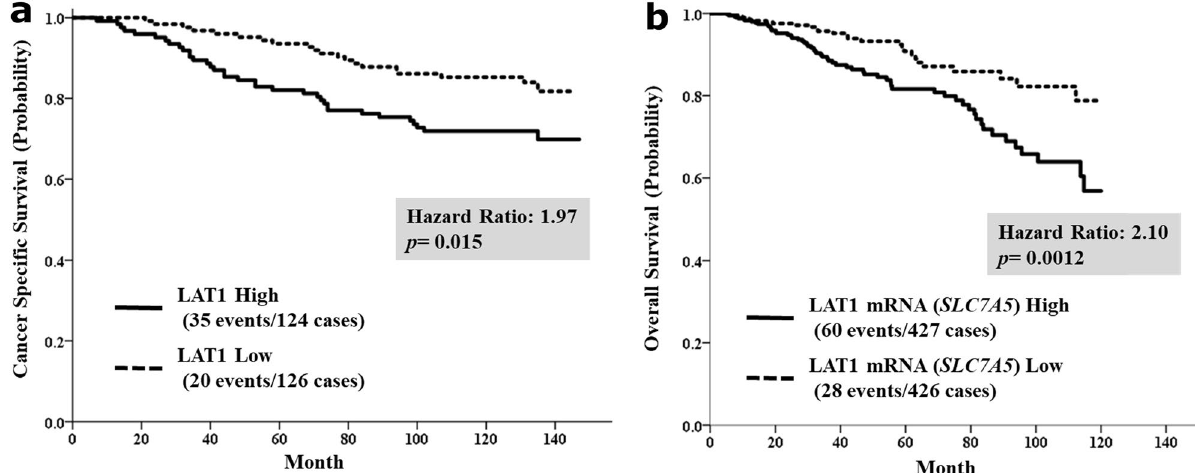
Figure 1. ( a ) Breast cancer-specific survival stratified by L-type amino acid transporter 1 (LAT1) protein expression, ( b ) overall survival stratified by LAT1 mRNA